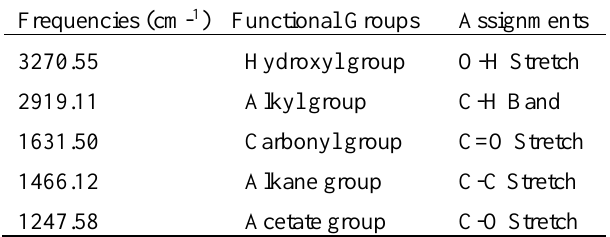
FTIR analysis of powdered neem